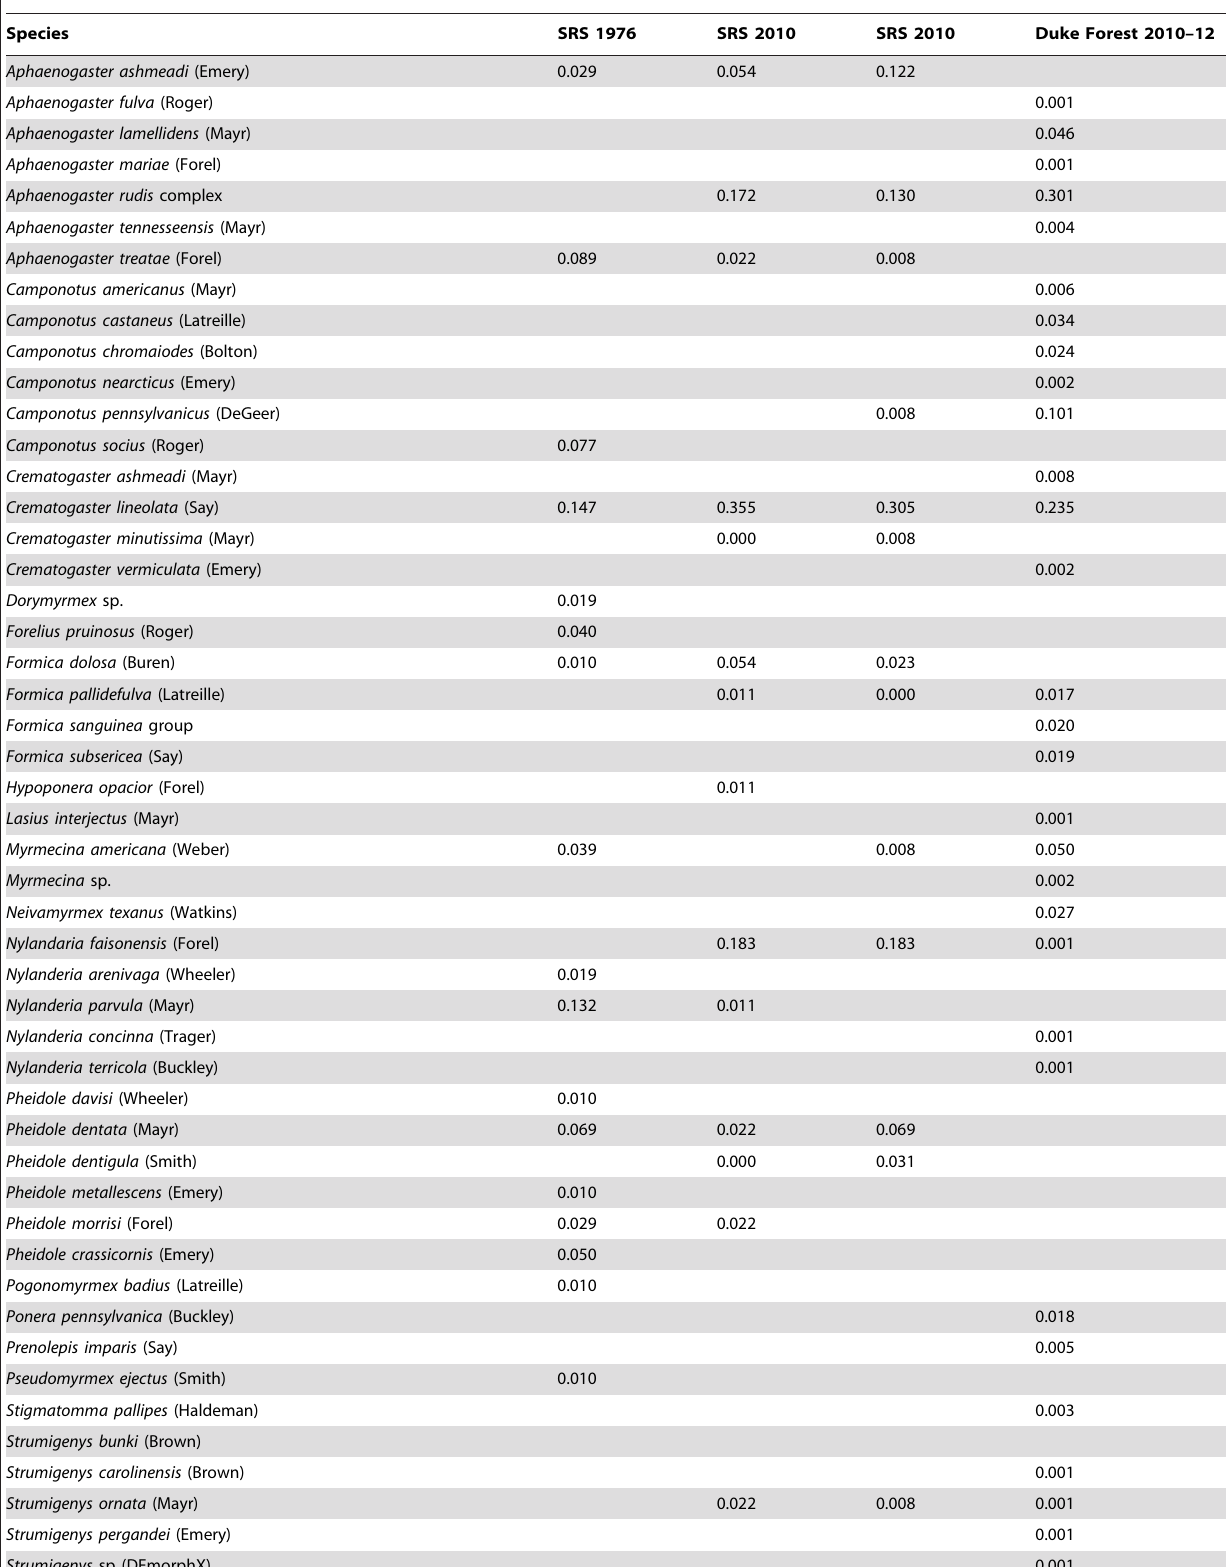
Table 1. Species list for Savannah River Site and Duke Forest for this study.